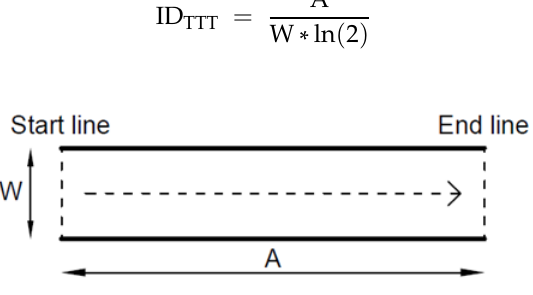
Figure 1. Representation of a Tunnel Traveling Task.